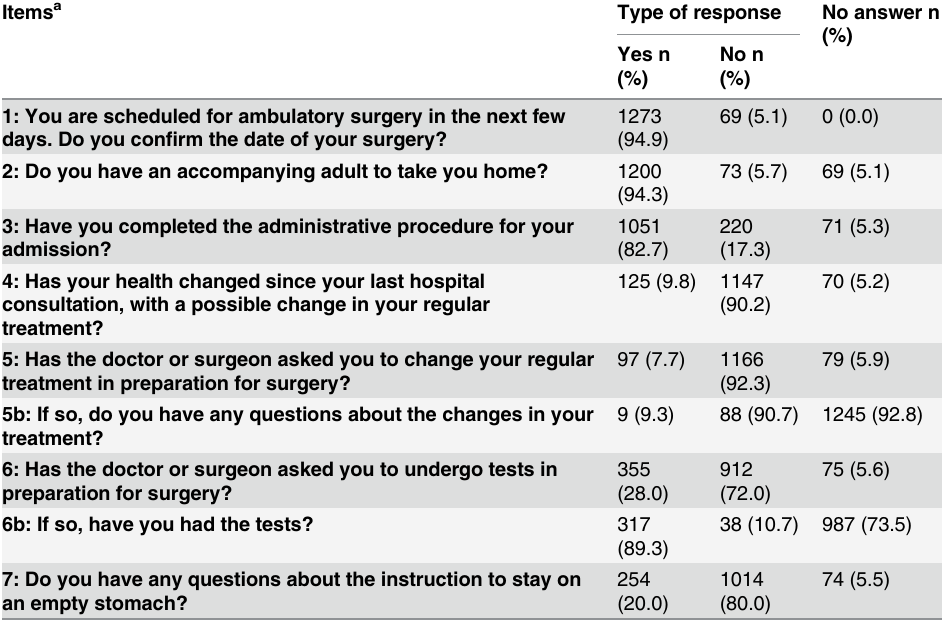
Table 3. Results of 1342 administered checklists.